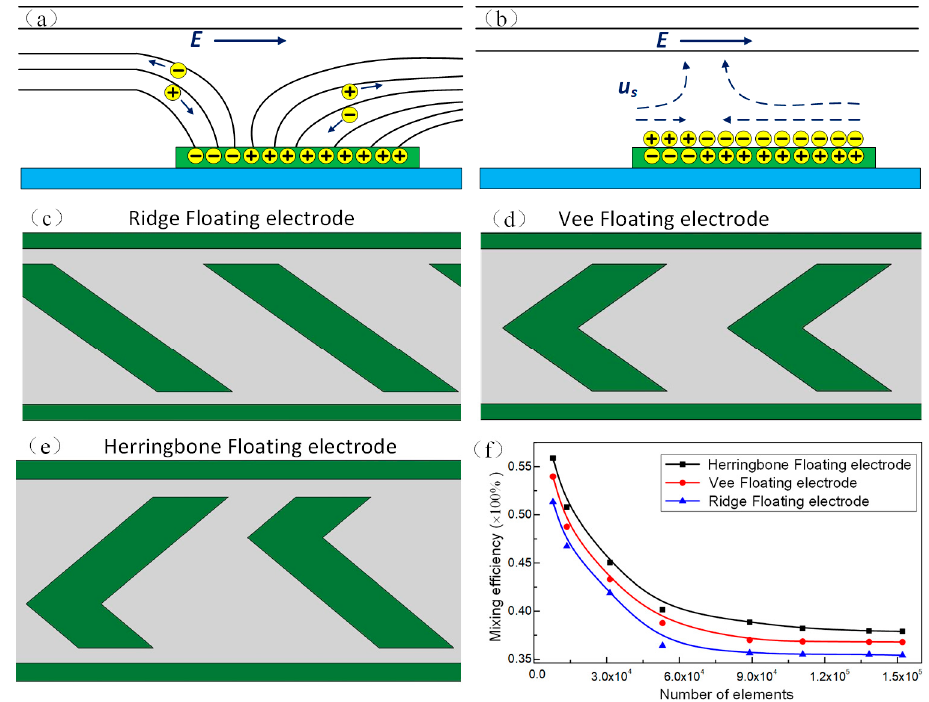
Figure 1. Schematic of induced charge electroosmotic (ICEO) flow on the polarizable metal strip and the ICEO slip velocity on the floating electrode with some deviation from the middle of driving electrodes. ( a ) The formation of the electric double layer on the floating electrode under the imposed external electrical field; ( b ) the asymmetrical ICEO microvortices above the polarizable floating electrode surface; ( c – e ) the Ridge/Vee/Herringbone type floating electrode microstructure; ( f ) the mesh independency test and the mixing efficiency at the outlet for the three types of metal strip with single electrode pair under the conditions of A = 5 V and f = 400 Hz.